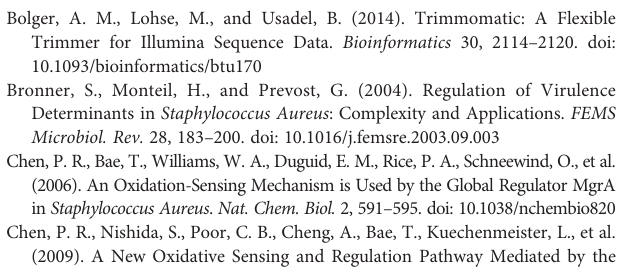
Supplementary Table 1 | TRQ-treated S. aureus regulon in exponential growth phase. (A) Locus tag, gene name, gene product, and functional classi fi cation were extracted from AureoWiki (Fuchs et al., 2018). (B) FC, fold change (log2 ratio). Supplementary Table 2 | RT-PCR primers used in this